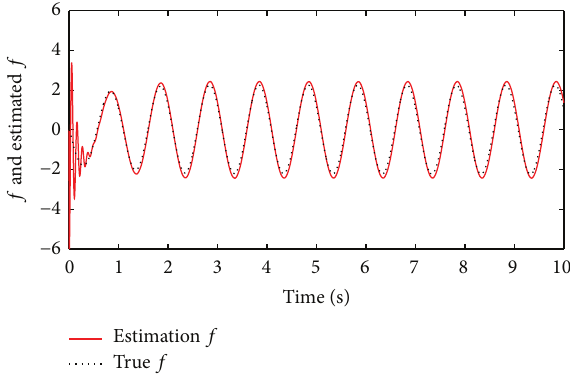
Figure 8: True and estimation 𝑓(𝑥) (Case 1).